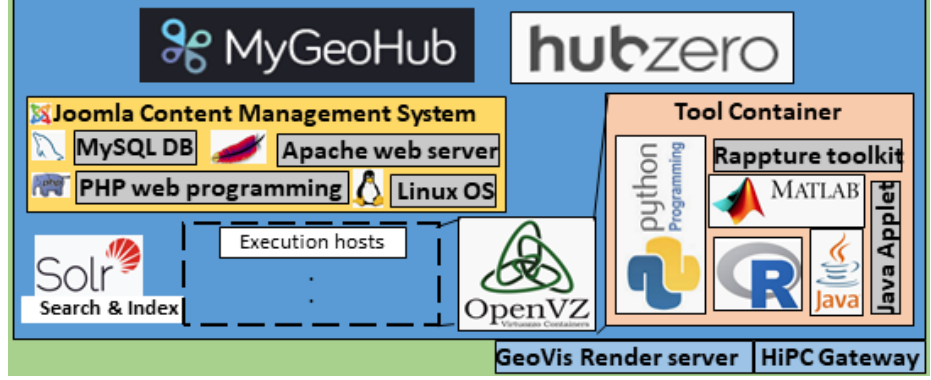
Figure 6. MyGeoHub Hubzero infrastructures; adapted from